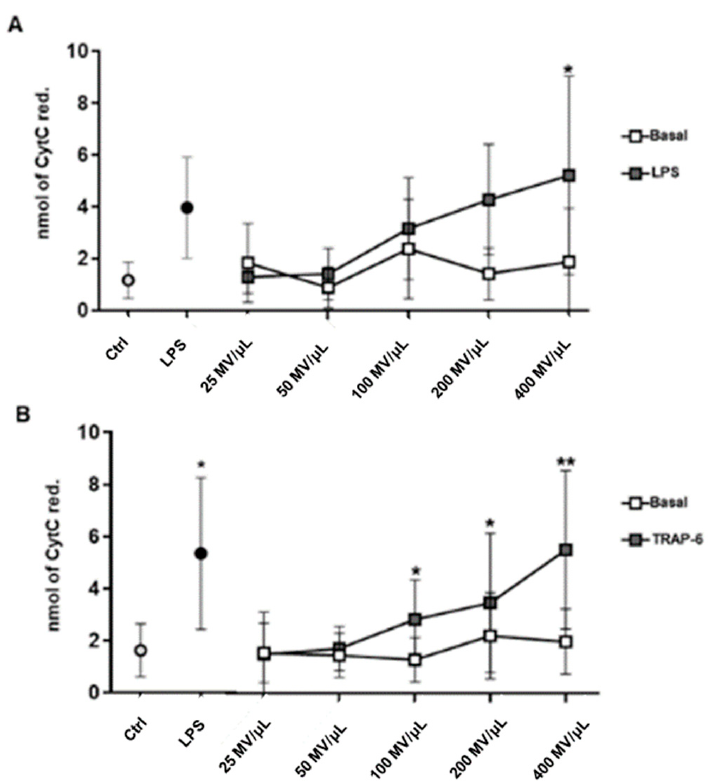
Figure 2. Monocyte- (Mo-) and platelet- (Plt-) MVs effect on superoxide anion production by hECV. Endothelial cells were incubated for 30 min with the reported concentration of Mo-MVs ( A ) and Plt-MVs ( B ) isolated from healthy subjects under resting conditions (basal) and upon stimulation with LPS (10 µg/mL) or TRAP-6 (20 µM). Data are expressed as nmoles of cytochrome C reduced/10 6 cells/30 min and are represented as mean ± SD of 9 independent experiments and analyzed by one-way ANOVA with Dunnett’s test for multiple comparison. * p < 0.05; ** p < 0.01 vs. respective untreated cells (Ctrl).